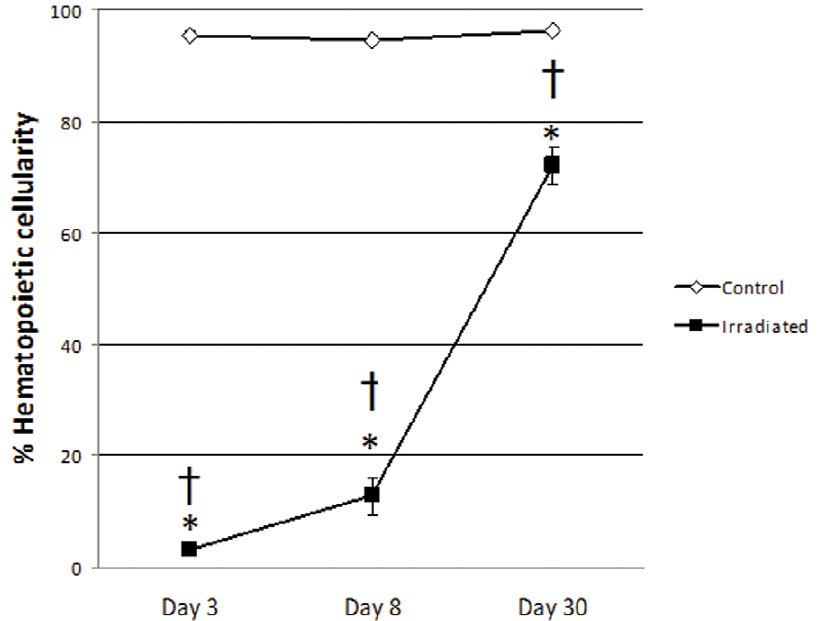
Figure 3. Percent of the marrow space (mean ± SEM) occupied by hematopoietic precursors in intact control (I 2 R) and irradiated (I + R) mice estimated by visual inspection by a board certified veterinary clinical pathologist (LS) employing standard protocols. Radiation caused marked hypocellularity of the hematopoietic components of the marrow by Day 3, with significant increases but still very low hematopoietic activity on Day 8 and marked but still incomplete recovery of hematopoietic activity with normal precursor maturation at Day 30. There were no changes over time in non-irradiated animals. Two-way ANOVA with Tukey’s post-tests: * Irradiated mice had significantly lower cellularity than control mice of the same day, p , 0.0001, { Cellularity of irradiated mice increased significantly from Day 3 through Day 30, p: 0.0292 – , 0.0001.